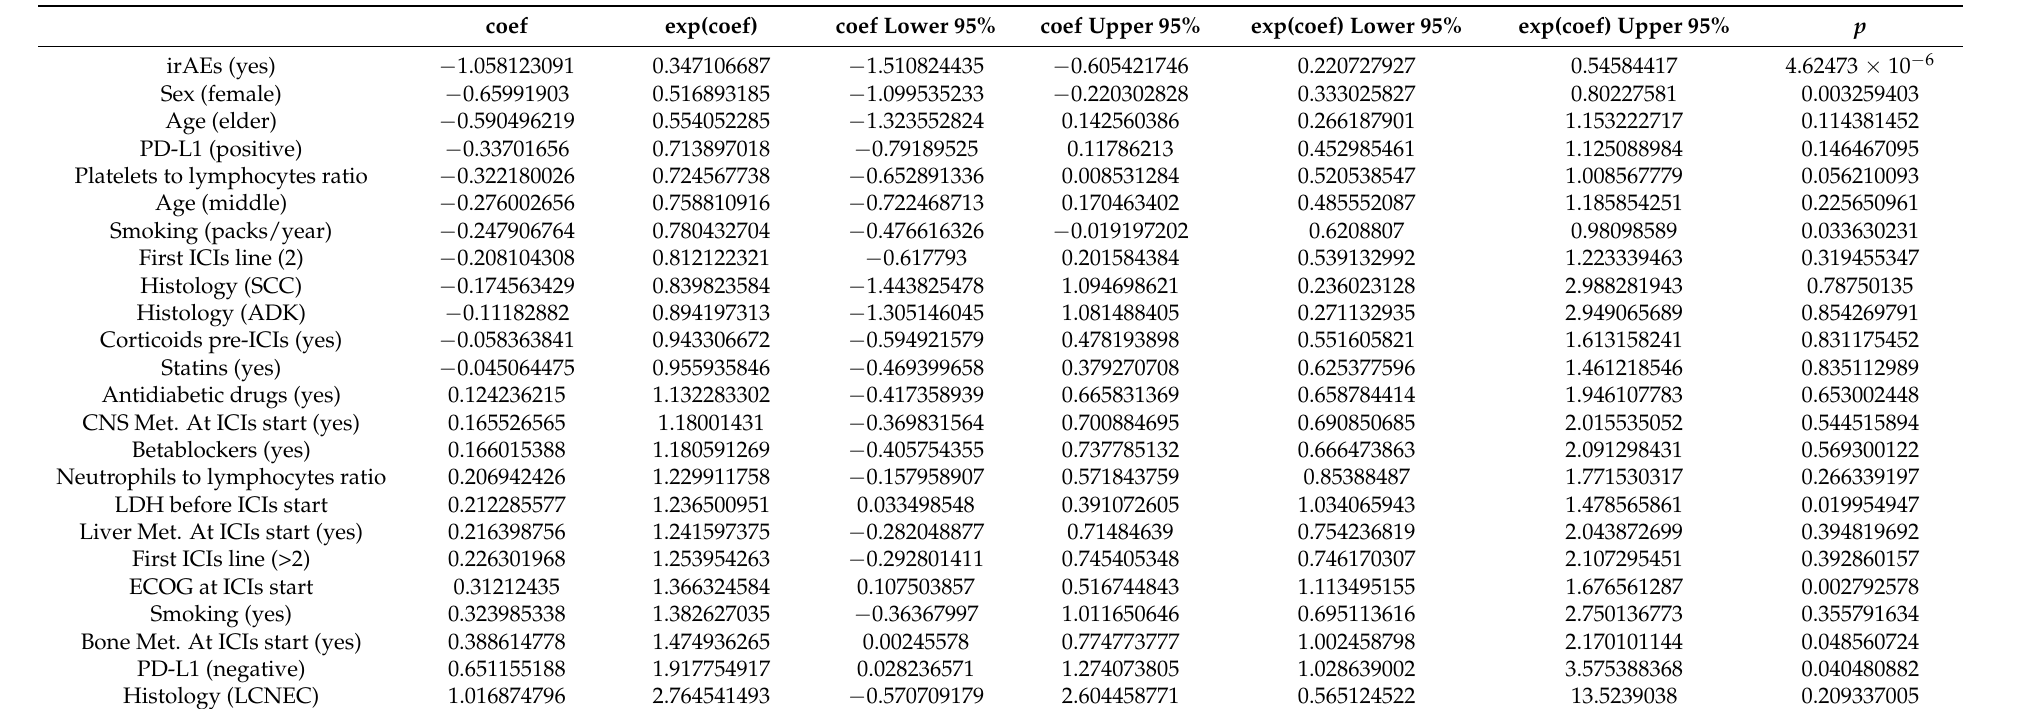
Table 2. Multivariate Cox proportional-hazards survival